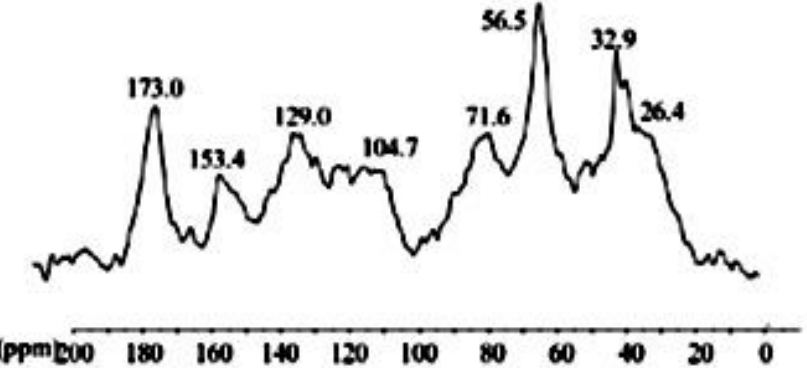
Figure 1. CPMAS- 13 C-NMR spectrum of humic acids isolated from vermicompost.